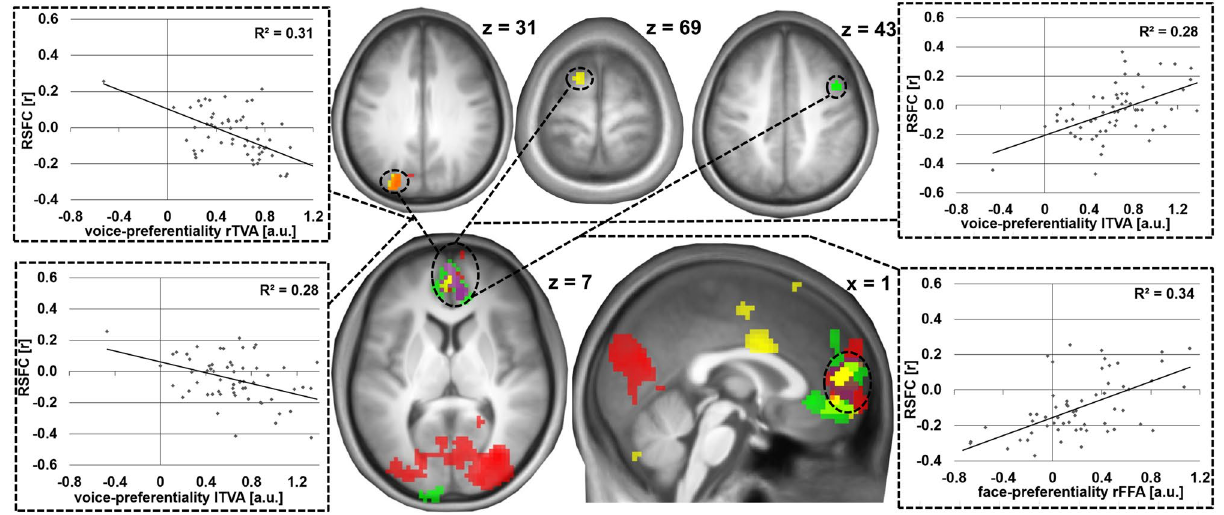
Figure 5. RSFC patterns informative of voice- and face-preferentiality: supramodal convergence using three regressors. Individual voice- and face-preferential responses were assessed using minimum difference criteria (for voices V > max[A, E], for faces F > max[H, O, S]). Top brain section: MVPA clusters used as seed regions [see also Fig. 2b,d] with the rTVA (red) and lTVA (yellow; overlapping region in orange) voice-preferentialities, as well as the rFFA face-preferentiality (green) as regressors. Bottom brain section: The seeds’ convergent RSFC patterns regarding individual voice-preferential responses of the right (red) and left (yellow) TVA and face-preferential responses of the right FFA (green), (purple: supramodal overlap). Results shown at a voxel- wise threshold of p < 0.001 and whole brain FWE-corrected at cluster level with a cluster threshold of p < 0.05. Coordinates refer to MNI space. The diagrams on the right illustrate the underlying association of voice- preferential responses and